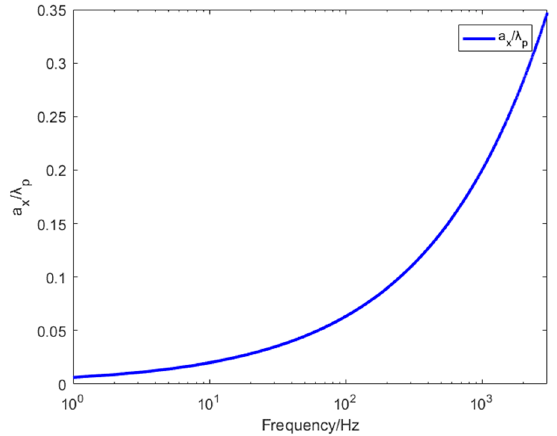
Figure 9. Lattice constant/length of the curved wave.